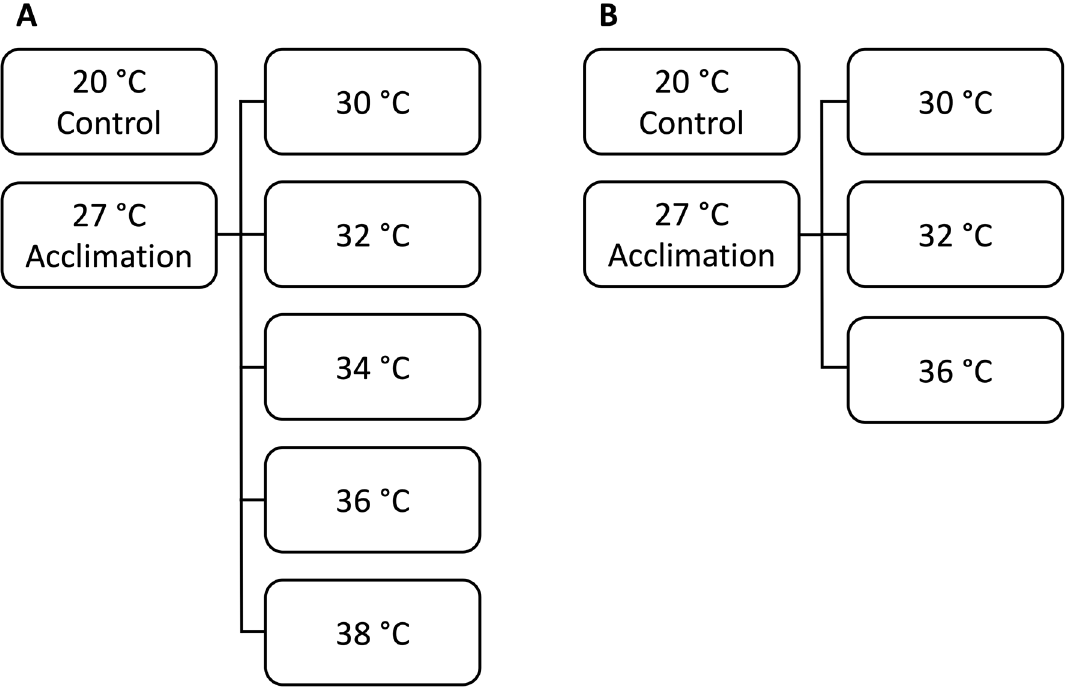
a non-acclimated control for ( A ) glochidia and ( B )